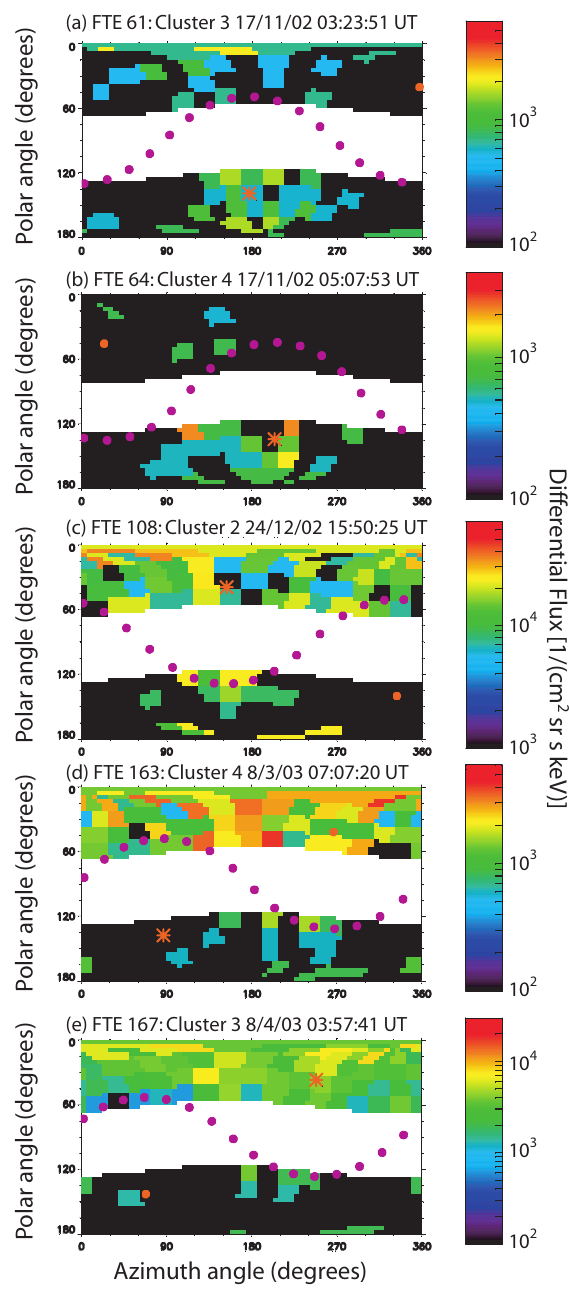
Fig. 15. RAPID high energy ion distributions for FTEs observed when the Cluster spacecraft were in burst mode. Each panel shows the differential number flux as an azimuthal/polar angle distribution. Parallel and antiparallel pitch angles are indicated by a red circle and star respectively, and perpendicular pitch angles are represented by purple circles. Data are unavailable from the central ion heads, corresponding to polar angles around 90 ◦